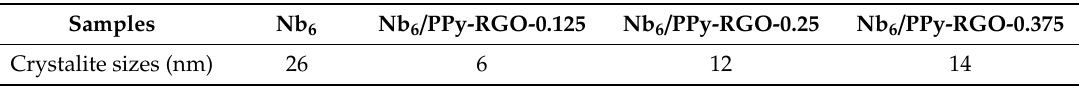
Figure 1. X-ray di ff raction (XRD) patterns of graphene oxide (GO), RGO (insert figure), Nb 6 and Figure 1. X-ray diffraction (XRD) patterns of graphene oxide (GO), RGO (insert figure), Nb 6 and Nb 6 / PPy-RGO composites. Nb 6 /PPy-RGO composites. Table 1. The crystallite sizes of Nb 6 and Nb 6 / PPy-RGO composites (Nb 6 = K 7 HNb 6 O 19 , RGO = reduced Table 1. The crystallite sizes of Nb 6 and Nb 6 /PPy-RGO composites (Nb 6 = K 7 Nb 6 O 19 , RGO = reduced graphene oxide, PPy = graphene oxide, PPy = polypyrrole).